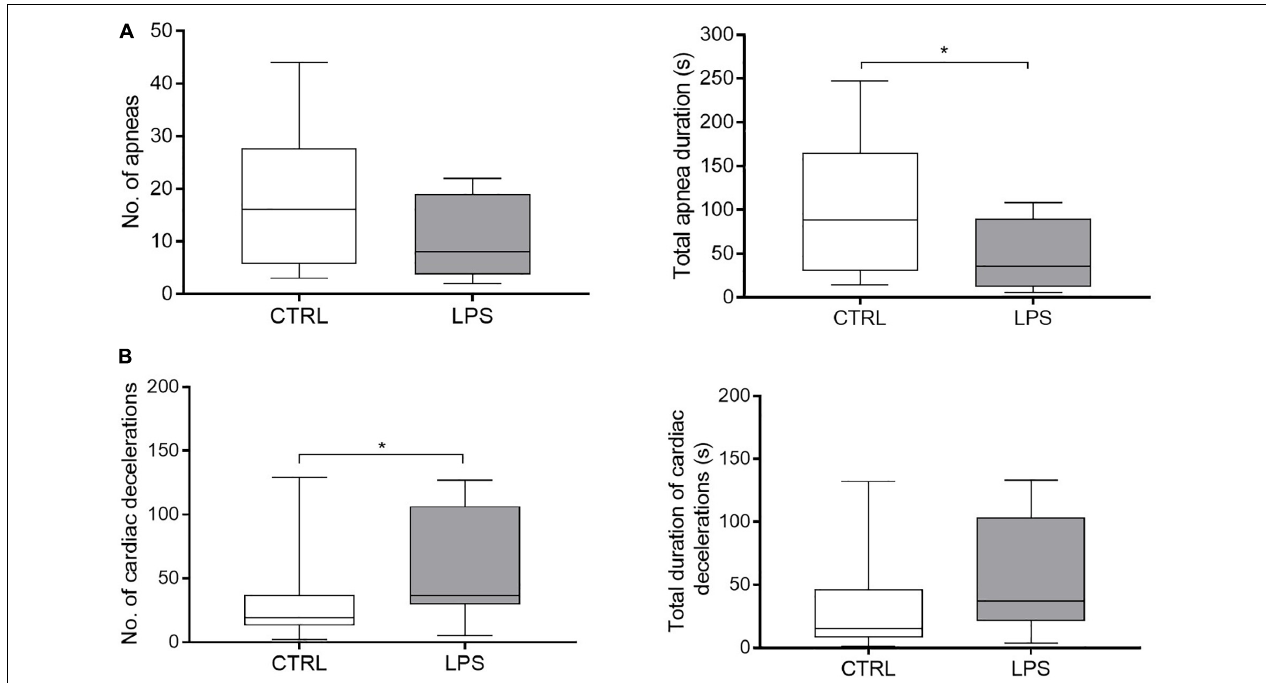
FIGURE 4 | Effects of lipopolysaccharide injection on apnea and cardiac decelerations. (A) LPS injection significantly decreased total apnea duration compared to the control condition, but did not change the number of apneas. (B) LPS injection increased the number of cardiac decelerations, while no difference was observed for the total duration of cardiac decelerations. No, number. Results are illustrated as median (Q1, Q3), * p < 0.05 vs. control condition